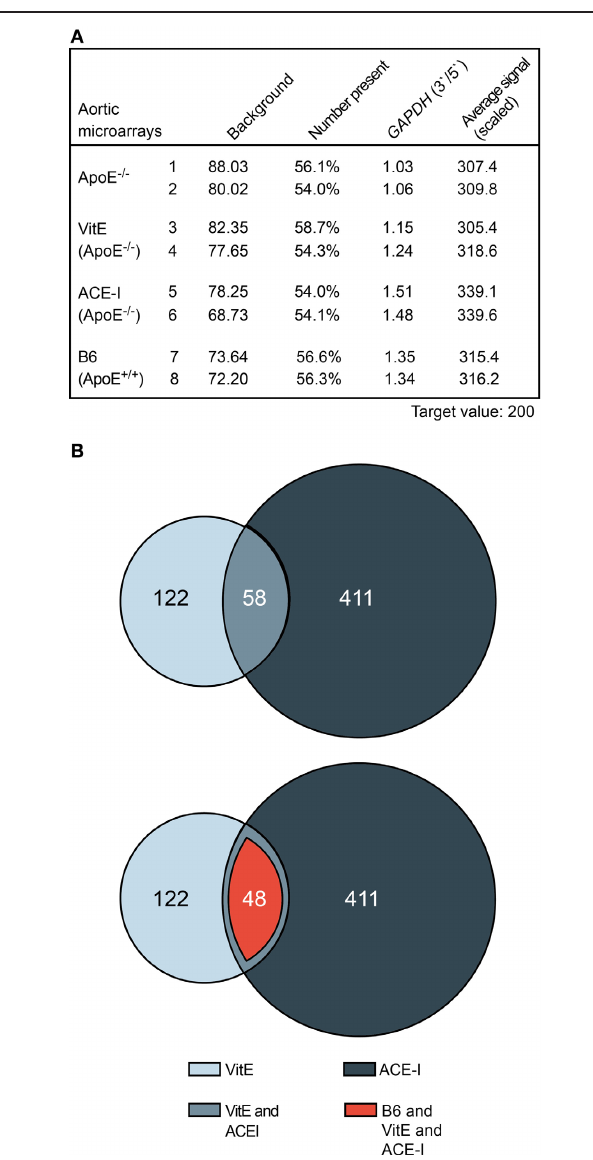
FIGURE 2 | Whole genome microarray gene expression profiling of atherosclerosis treatment with vitamin E and captopril revealed concordantly regulated aortic genes. (A) Characteristics of aortic microarrays used for data analysis. Two different gene chips are presented of each study group. For each gene chip (Affymetrix GeneChip MG430 2.0 Array with more than 45,000 probe sets), RNAs from three different aortas were pooled. (B) The upper panel presents a Venn diagram illustrating that 58 significantly different probe sets showed concordant regulation between aortas isolated from vitamin E-treated (VitE) and captopril-treated (ACE-I) ApoE − / − mice relative to untreated ApoE − / − mice. Probe sets with significant difference ( P ≤ 0 . 01; ≤− 2-fold or ≥ 2-fold difference, signal intensity ≥ 100 and/or call present) between vitamin E-treated and non-treated ApoE − / − mice (180), and captopril-treated and non-treated ApoE − / − mice (469) were identified and used for further analysis. The lower panel illustrates that 82.8% (i.e., 48 probe sets) of concordantly regulated probe sets between vitamin E- and captopril-treated ApoE − / − aortas showed normalization toward B6 control level.